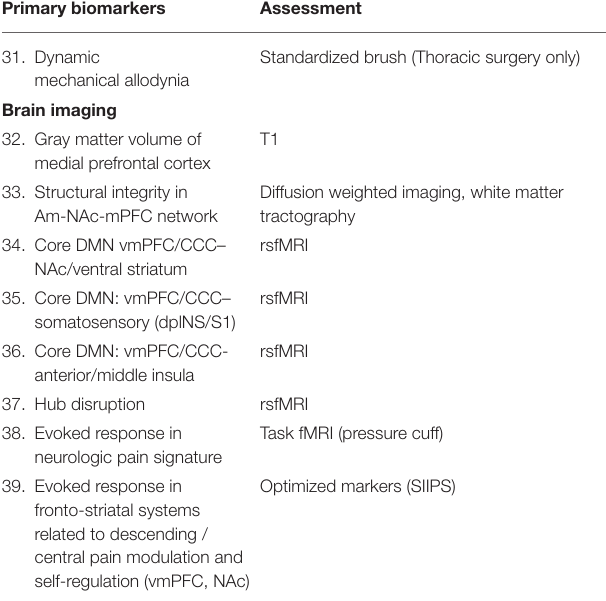
TABLE 2 | Primary biomarkers and